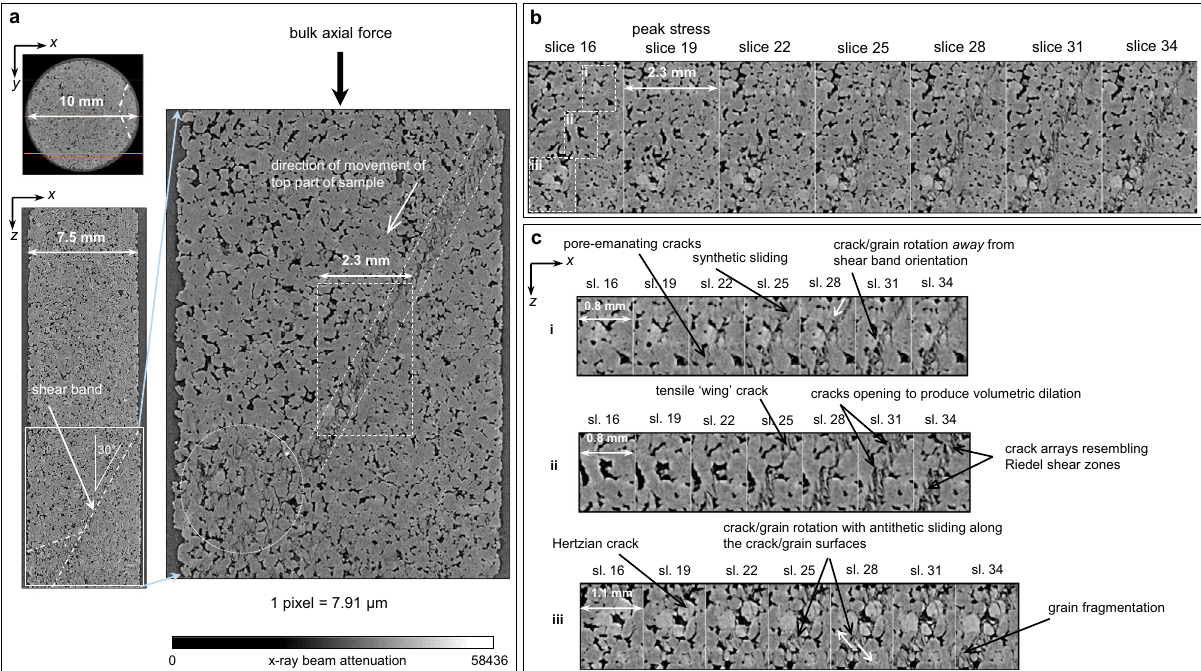
Fig. 2 | Microscale damage evolution close to and following peak stress. a Reconstructed2DX-raymicrotomographic( μ CT)slice( x,y -oriented,where x and y are perpendicular to each other and to the direction of loading, and x is across- strikeand y isalong-strikeoftheshearzone)showingtheplane(orangeline)ofare- slice of the original μ CT volume ( x,z -oriented, where z is the direction of loading) where the shear zone initially localised. The corresponding across-strike ( x,z - oriented) re-sliceis shown directly belowthe x,y -oriented slice with the shearzone highlightedbydash-dotlines.Zoomed-inviewoftheportionofthe x,z -orientedre- slice contained within the solid box is shown between the pale blue arrows, high- lightingthenarrowshearzonethatformedafterpeakstress(betweenthedash-dot lines), and the region of damage that formed after yield but before peak stress (dotted circle). b Further zoomed-in view of the across-strike slices ( x,z -oriented) for selected tomograms, labelled with the number by which they appeared in the